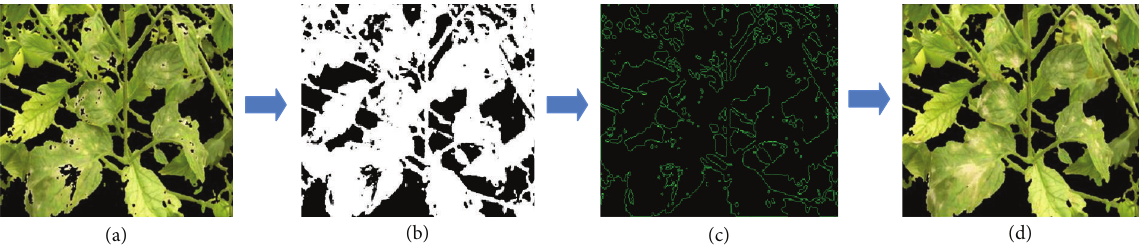
Figure 6: A process that extracts and selects contours which encloses disease areas. (a) Image segmented with the Bayesian classifier, (b) binary image, (c) contour extraction, and (d) recovering of contours corresponding to vegetation/disease areas and noise